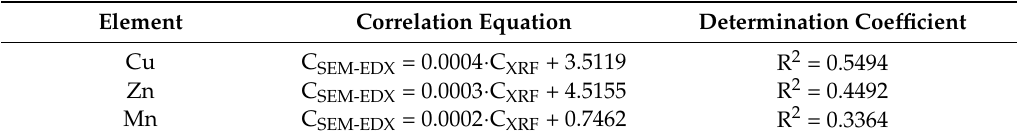
Table 6. Correlation equations for C SEM-EDX = f(C XRF ), mg/kg. Element Correlation Equation